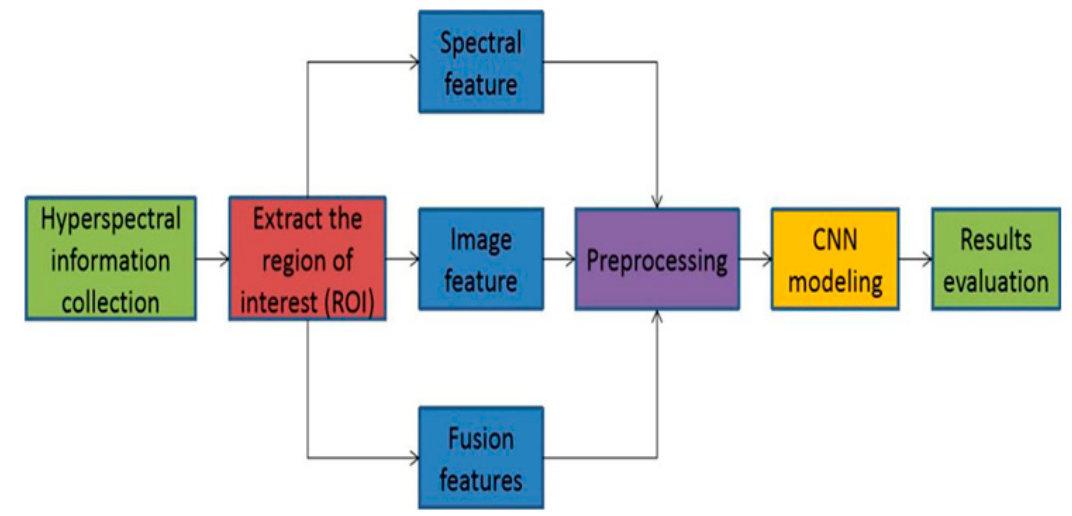
Figure 6. Schematic overview of the data procedures.